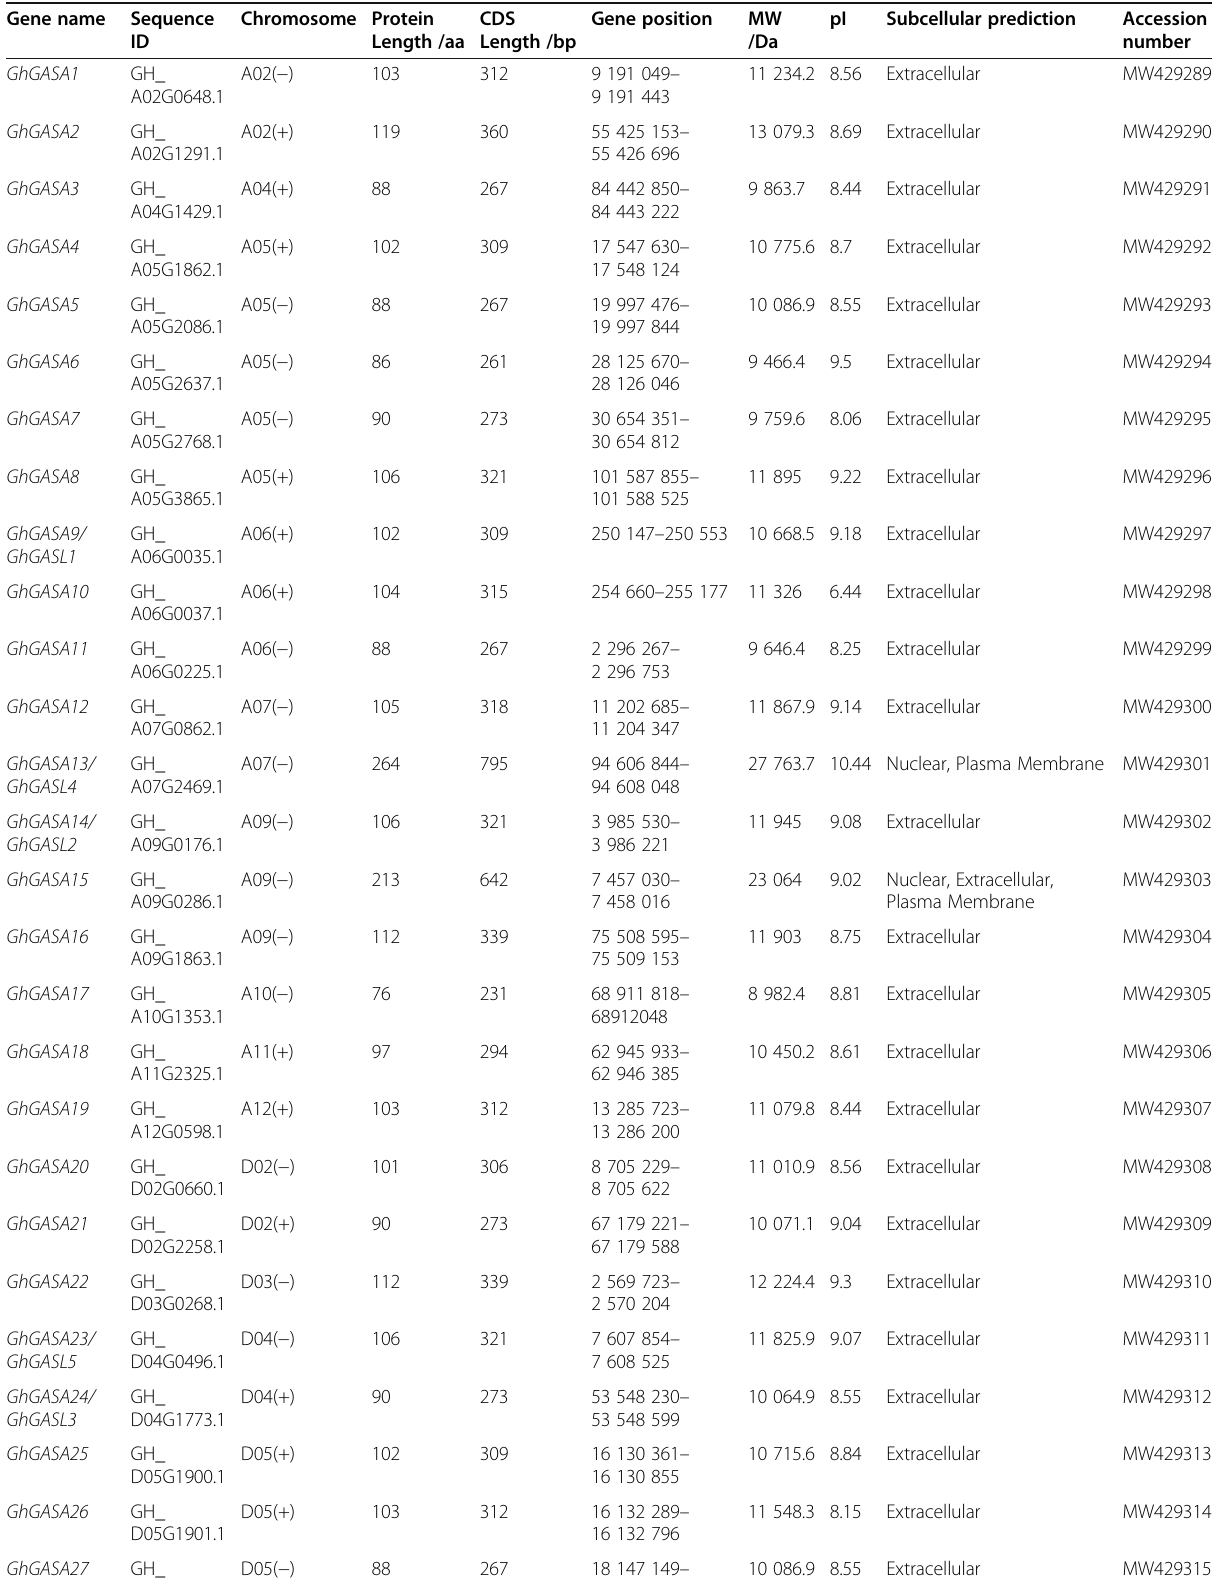
Table 1 Information of the GASA genes in G.